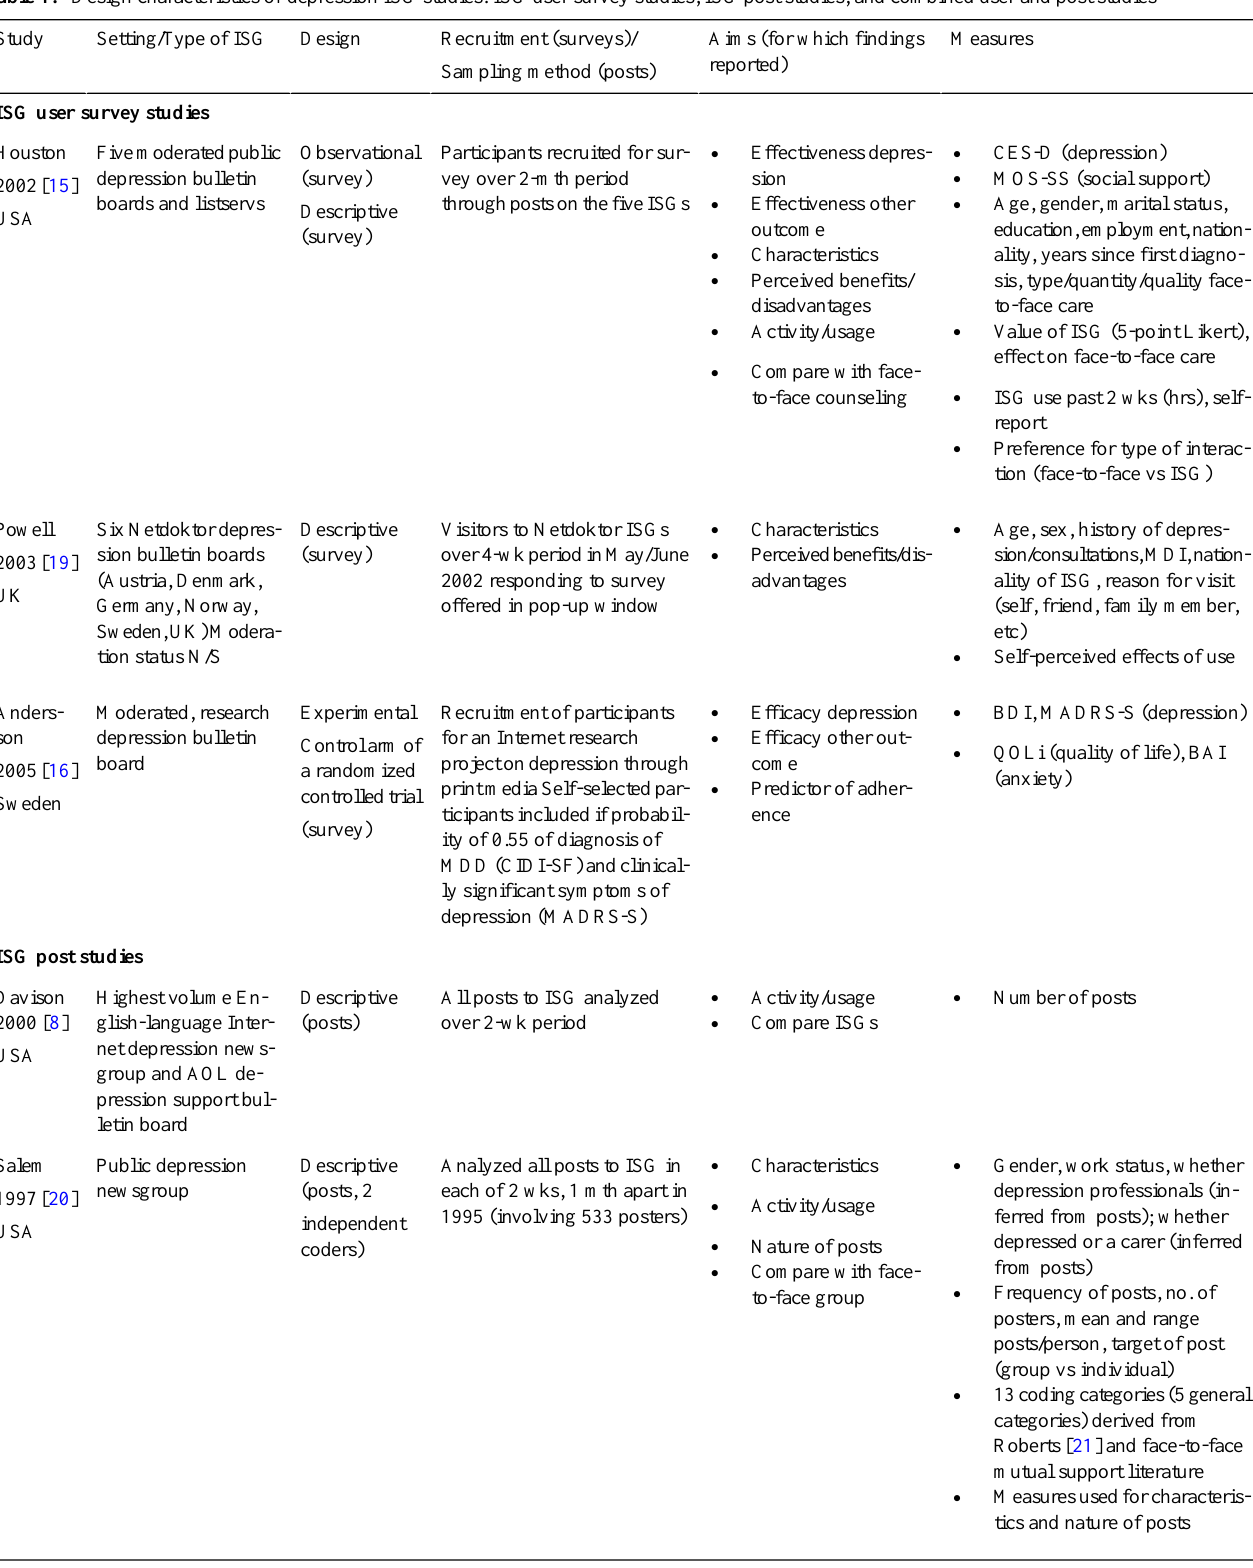
Table 1. Design characteristics of depression ISG studies: ISG user survey studies, ISG post studies, and combined user and post studies